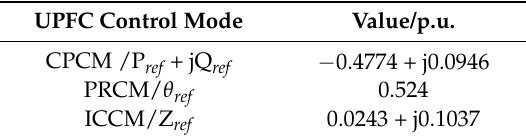
Table 1. The control targets values of three control modes.